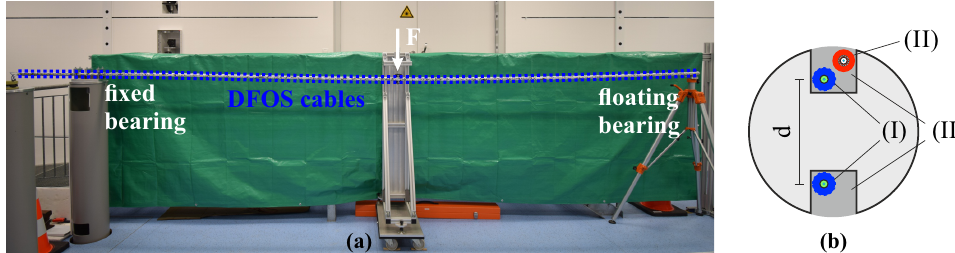
Figure 7. Laboratory testing of steel rod specimen [55]: ( a ) Practical test setup. ( b ) Installation scheme with (I) strain sensing cable, (II) temperature sensing cable, and (III) gluing groove.